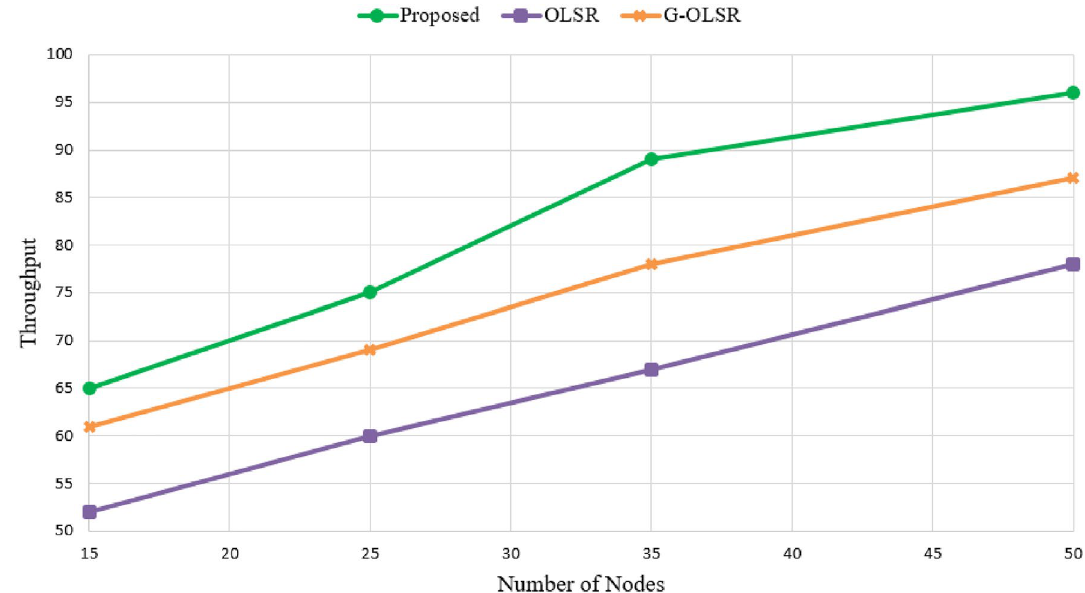
Figure 11. Comparison of different routing methods in terms of throughput.